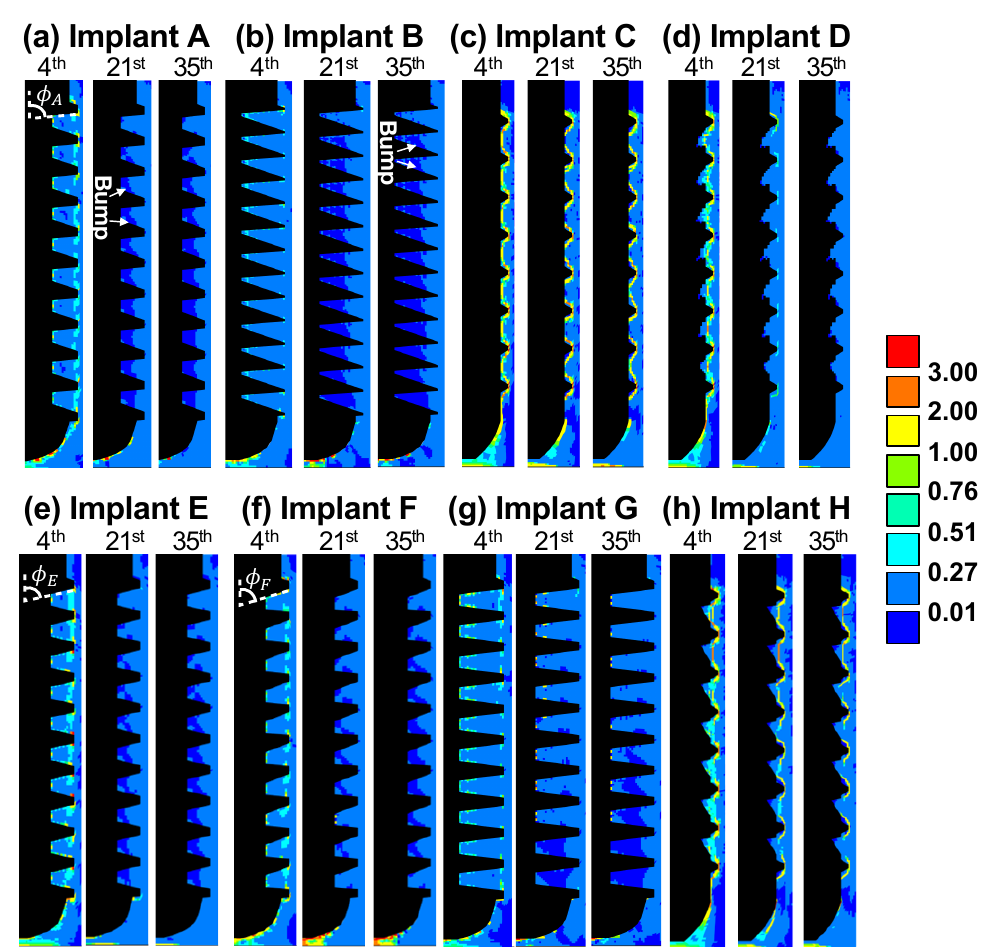
Figure 3. ( a – h ) The contour plots of solid stimulus for implants A to H, on the 4th, 21st, and 35th